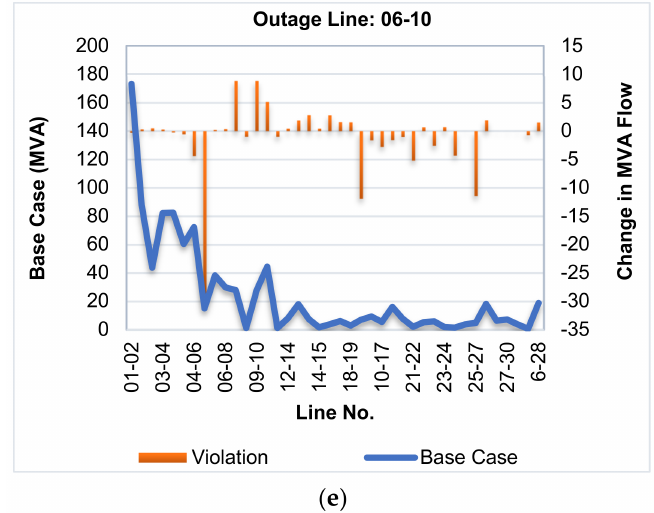
Figure 4. Different congestion scenarios in IEEE 30-bus System.